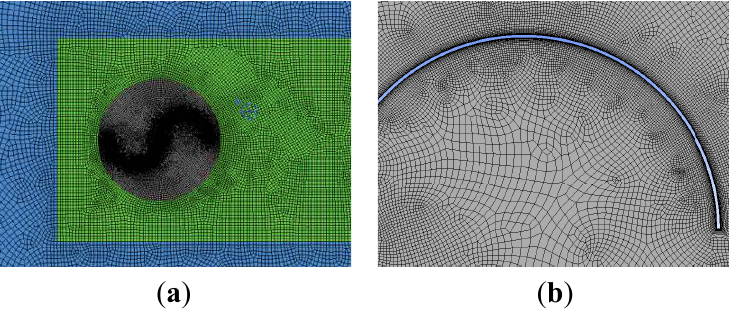
Figure 4. Grid generation for ( a ) the station domain and ( b ) the boundary